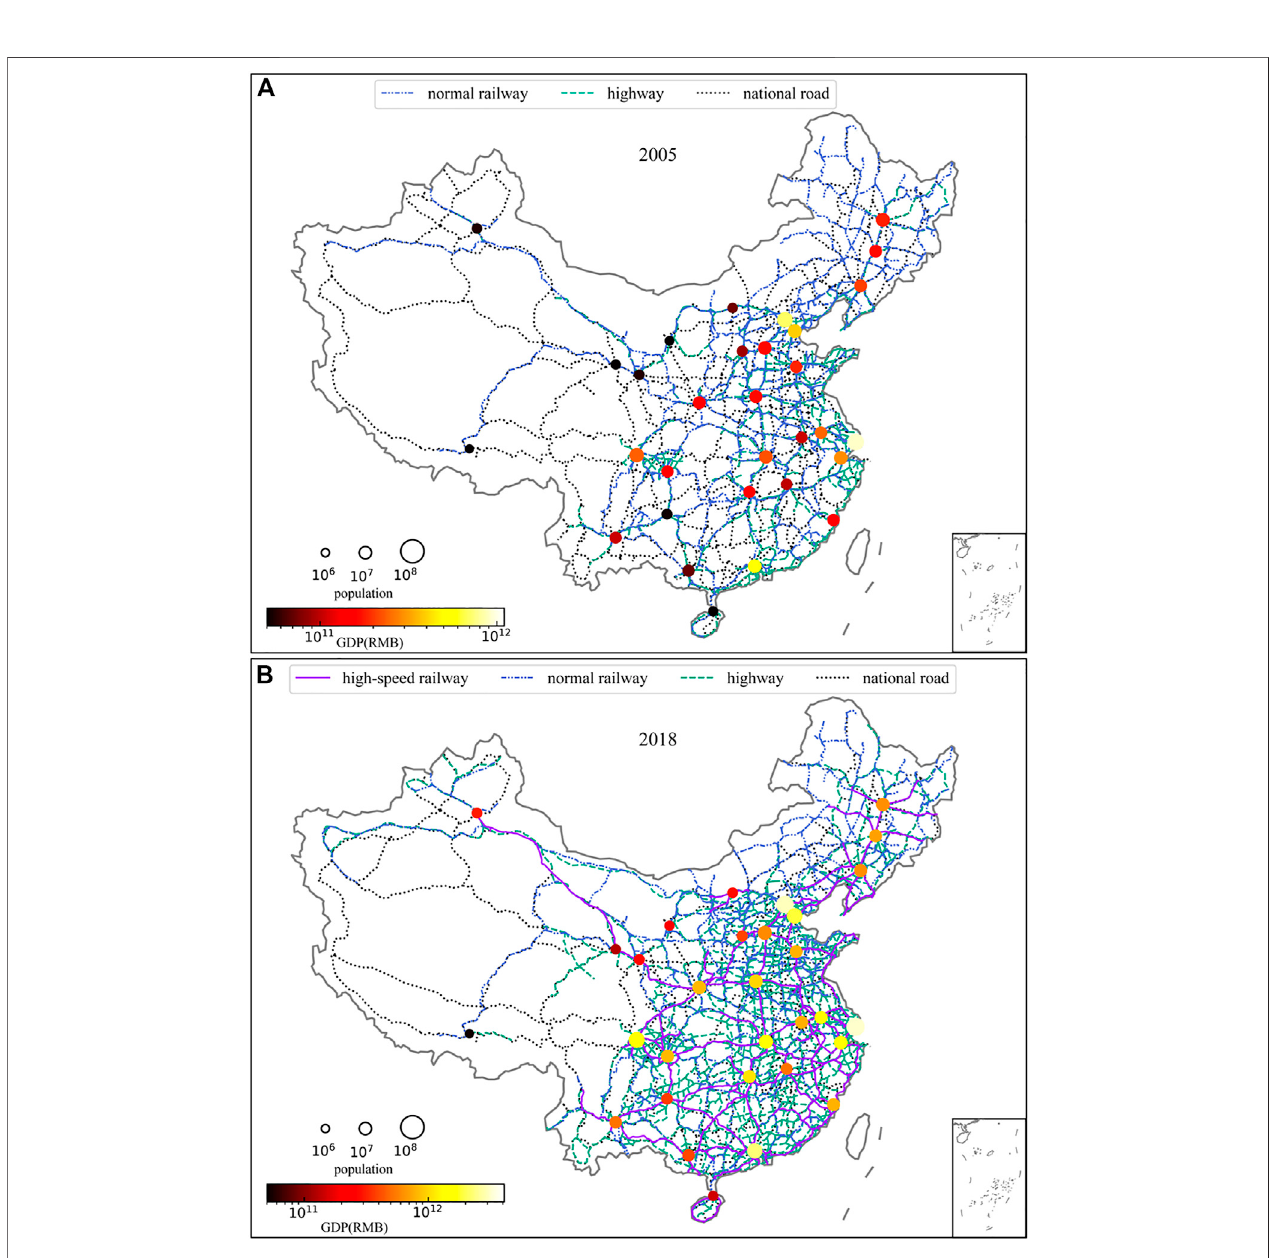
FIGURE 2 | Chinese land transportation network and selected important cities (A) 2005. (B) 2018. Each circle represents a provincial capital city or municipality. The size and color of the circle represent the population and GDP of the city, respectively. Solid lines represent high-speed railways, dashed-dotted lines represent normal railways, dashed lines represent highways, and dotted lines represent national roads.